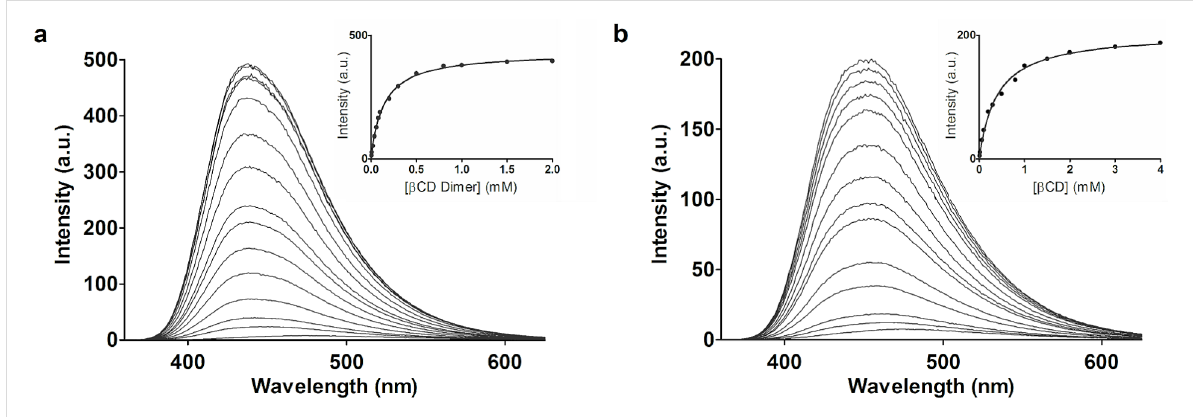
Figure 6: Steady-state fluorescence titration of 2,6-ANS with β -CD dimer and parent β -CD in solution. 2,6-ANS (50 µM) was titrated with 0 to 2 mM β -CD dimer (a) and 0 to 4 mM parent β -CD (b). The FI increases with respect to increasing concentration of β -CD dimer or β -CD. Inserts: Binding isotherms derived from the increase in FI at 420 nm as a function of β -CD dimer or β -CD concentration.